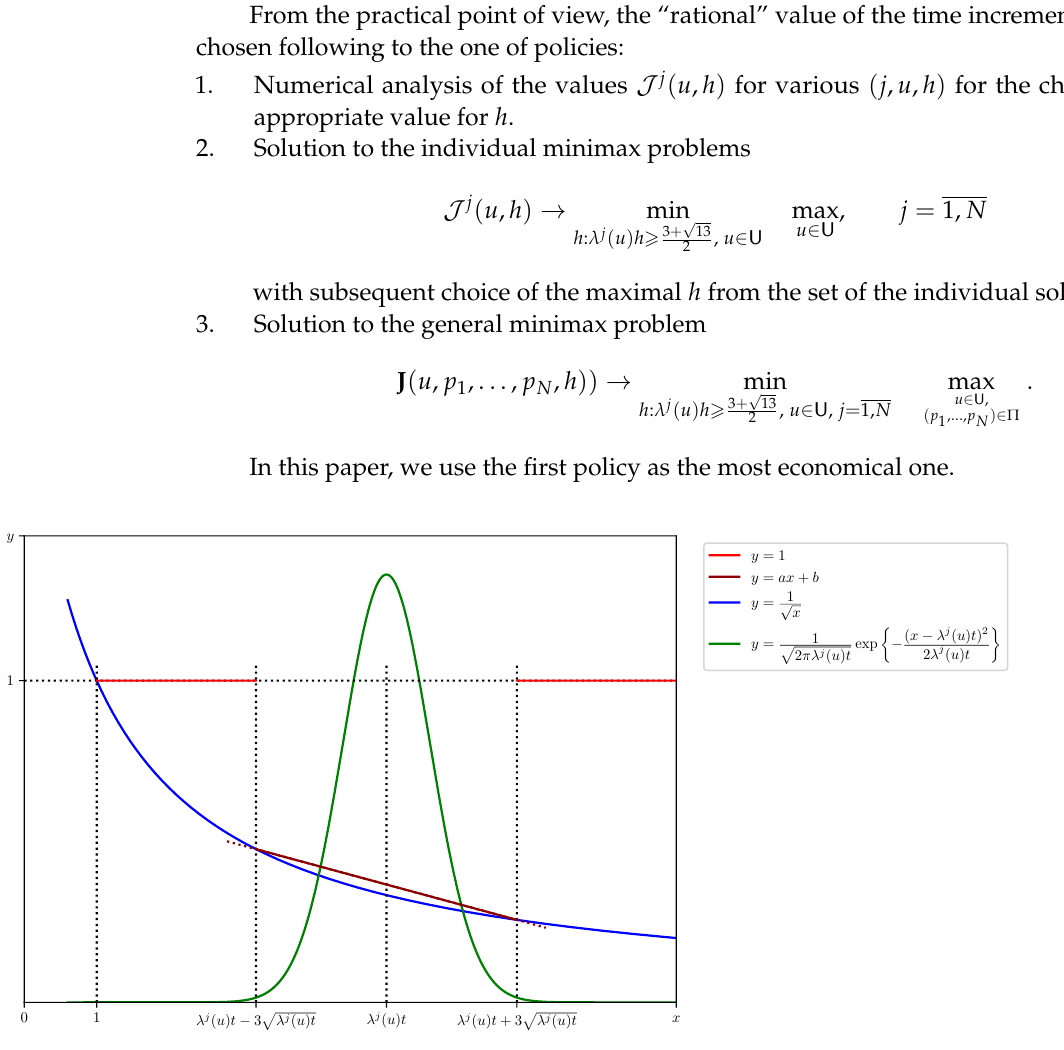
Figure 1. The function y = 1 and its piecewise linear majorant against the √ x